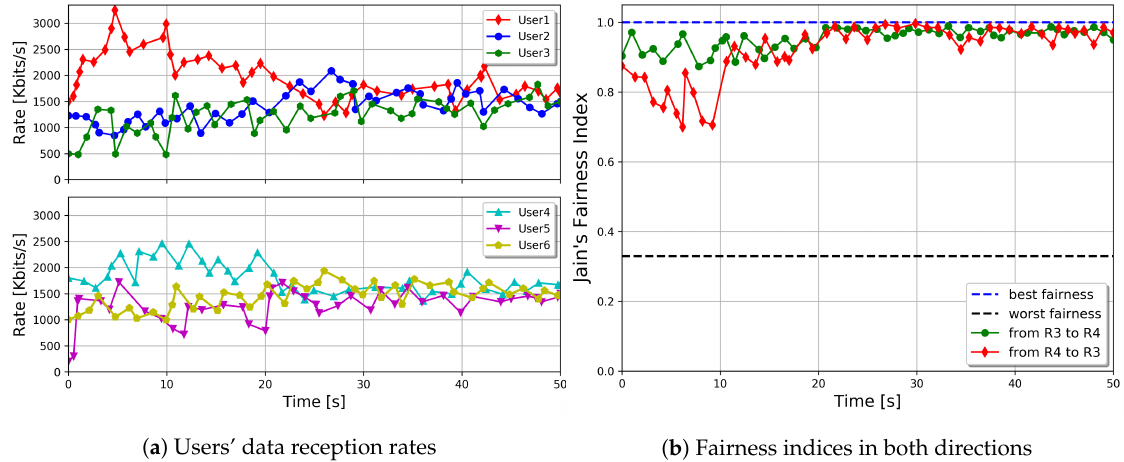
Figure 7. Performance evaluation of the proposed fairness scheme (parking lot